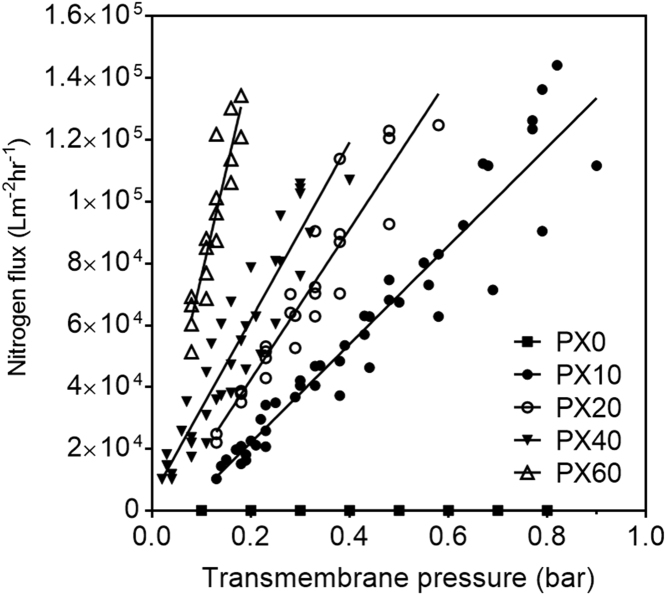
Flux of nitrogen through hollow fibres measured at a range of transmembrane pressures (n = 4). PX0 fibres were not gas permeable and ruptured at approximately 1 bar.